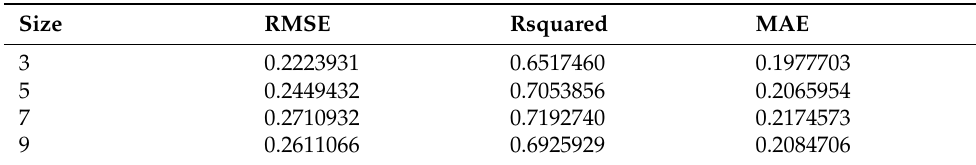
Table 4. Errors values for different number of neurons in hidden layer of MLP with sigmoid activation function.